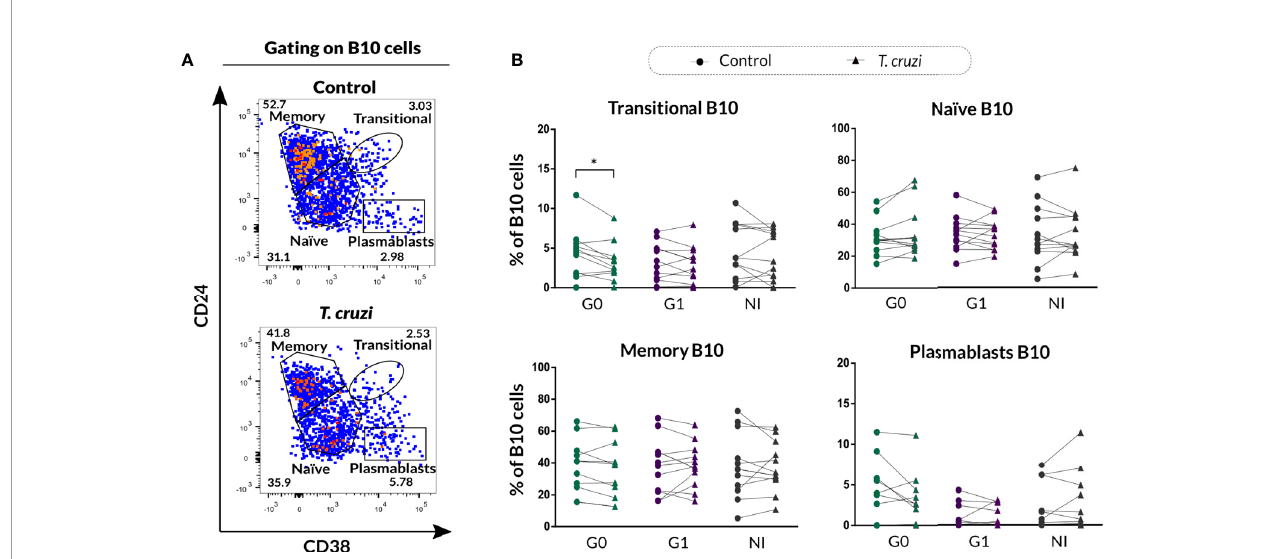
FIGURE 4 | Phenotypic distribution of B10 cells based on CD24 and CD38 expression from patients with CCD and NI donors upon T. cruzi stimulation. (A) Dot plots showing the gating strategy used to identify B10 cell subsets according to CD24 and CD38 expression for one NI donor. Large dots were used to facilitate visibility of events. (B) Frequency of transitional, naïve, memory, and plasmablasts B10 cell subsets in Control or T. cruzi stimulated B cells from CCD patients (G0, G1) and NI donors. Each symbol represents data from one individual. Statistically signi fi cant differences are indicated with an asterisk (*) p < 0.05.